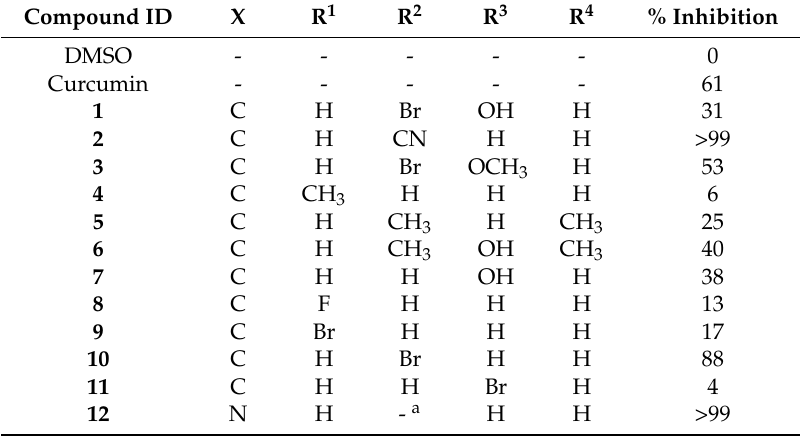
Table 1. Screening for identifying potent CBP HAT inhibitors by determining the percent inhibition in Dox-mediated activation of p53 response element in U2OS cells treated with 500 nM of cy - C 5 -curcuminoid analogs with modifications on sides.